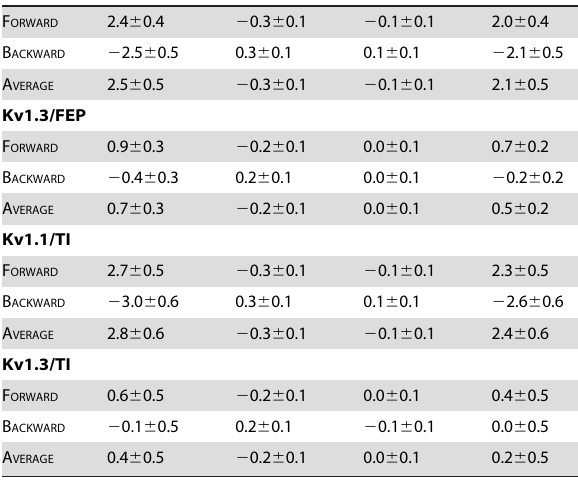
Table 2. Differences in the binding free energy of ShK to Kv1.1 and Kv1.3 due to the K18A mutation, calculated with the FEP and TI methods.